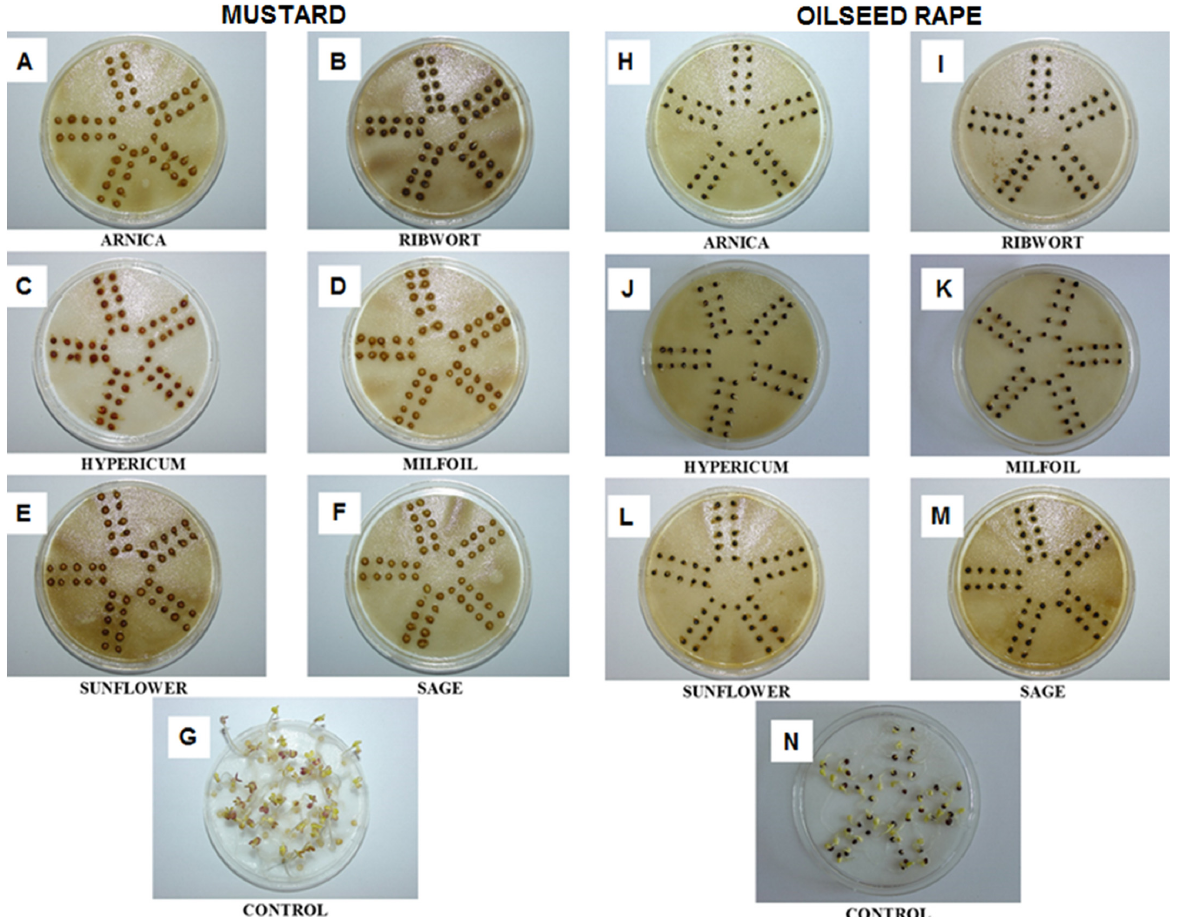
Figure 2. Germination of white mustard seeds on the 10% ( w/v ) extracts of arnica ( A ), ribwort ( B ), hypericum ( C ), milfoil ( D ), sunflower ( E ) and sage ( F ). The white mustard seeds of the control ( G ) were cultured only in water. Germination of the oilseed rape seeds on the 10% ( w / v ) extracts of arnica ( H ), ribwort ( I ), hypericum ( J ), milfoil ( K ), sunflower ( L ) and sage ( M ). The oilseed rape